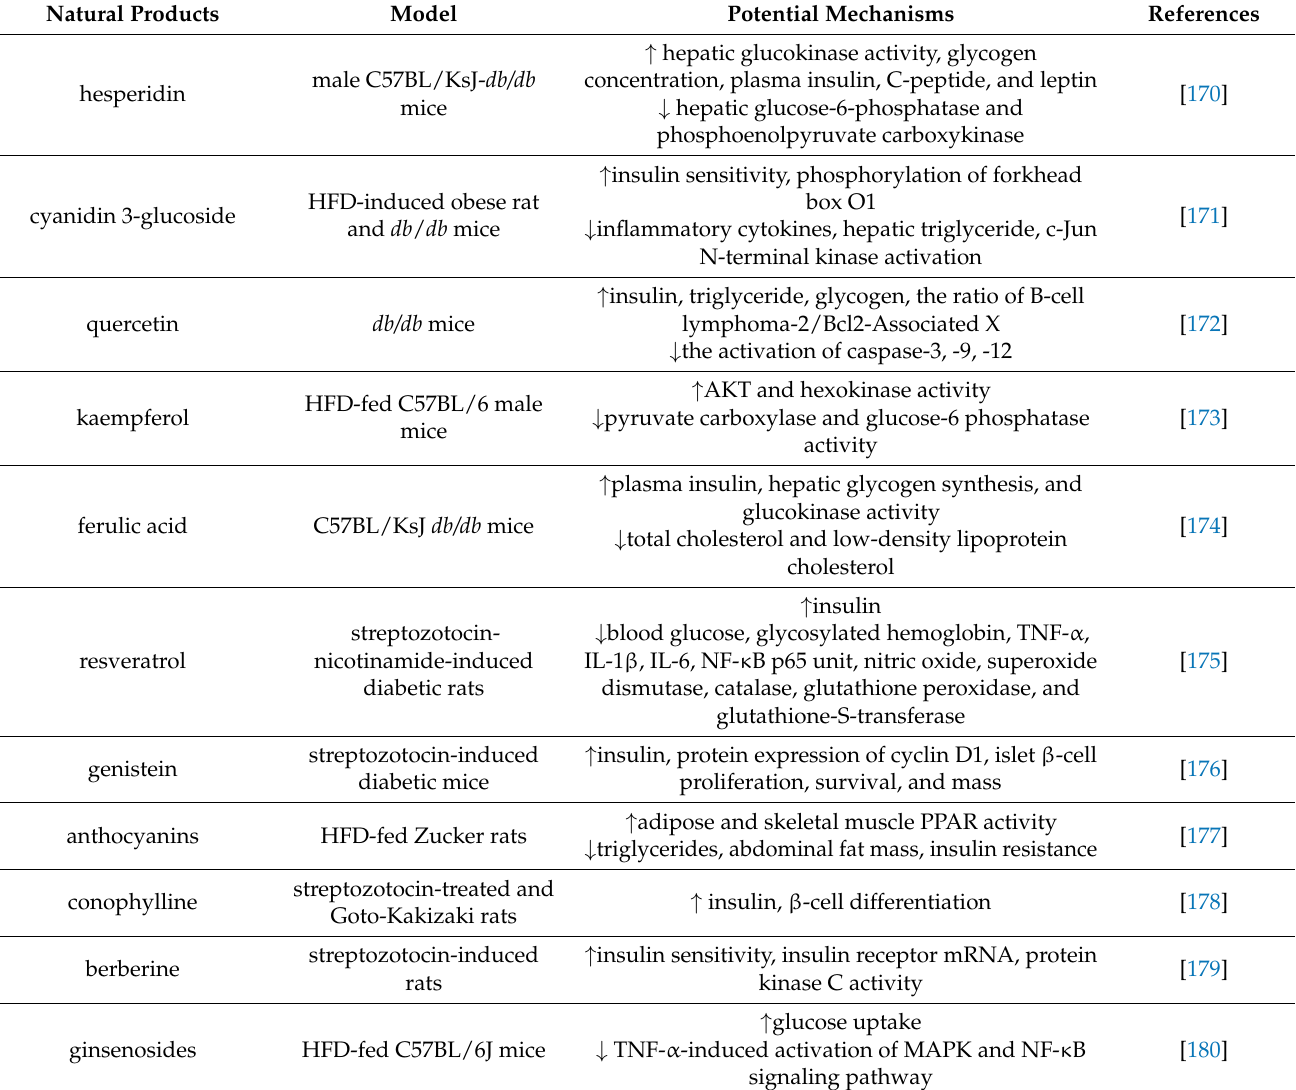
Table 4. Potential mechanisms of natural products in foods in animal models of